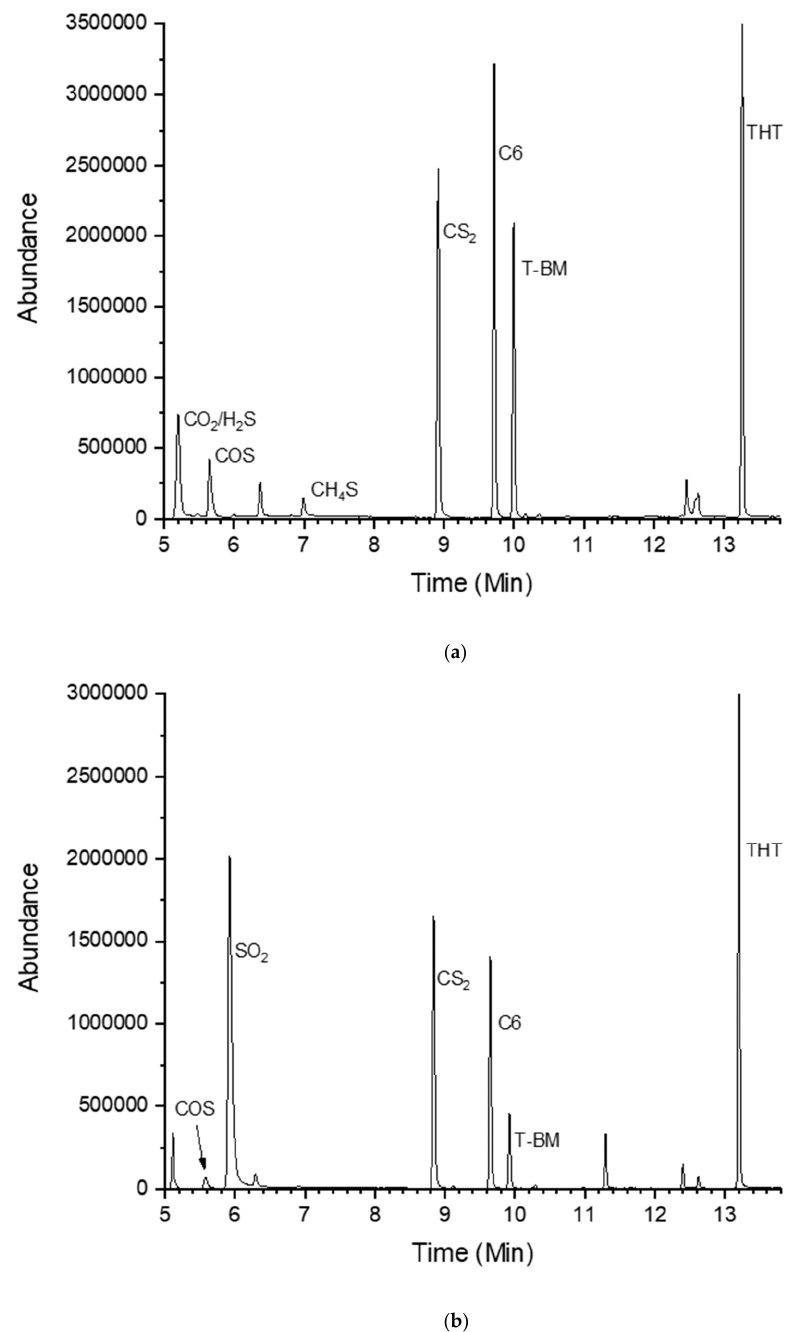
Figure 7. ( a ) Chromatogram analysis of VSL162904 containing approximately 400 nmol/mol per sulphur component (CO2: carbon dioxide, H2S: hydrogen sulphide, COS: carbonyl supplied, CH4S: methyl-mercaptan, C6: Hexane, T-BM: tert-butyl-mercaptan, THT: tetrahydrothiophene). ( b ) Chromatogram analysis of the sulphur compounds (at ~100 nmol / mol) on Carboxen